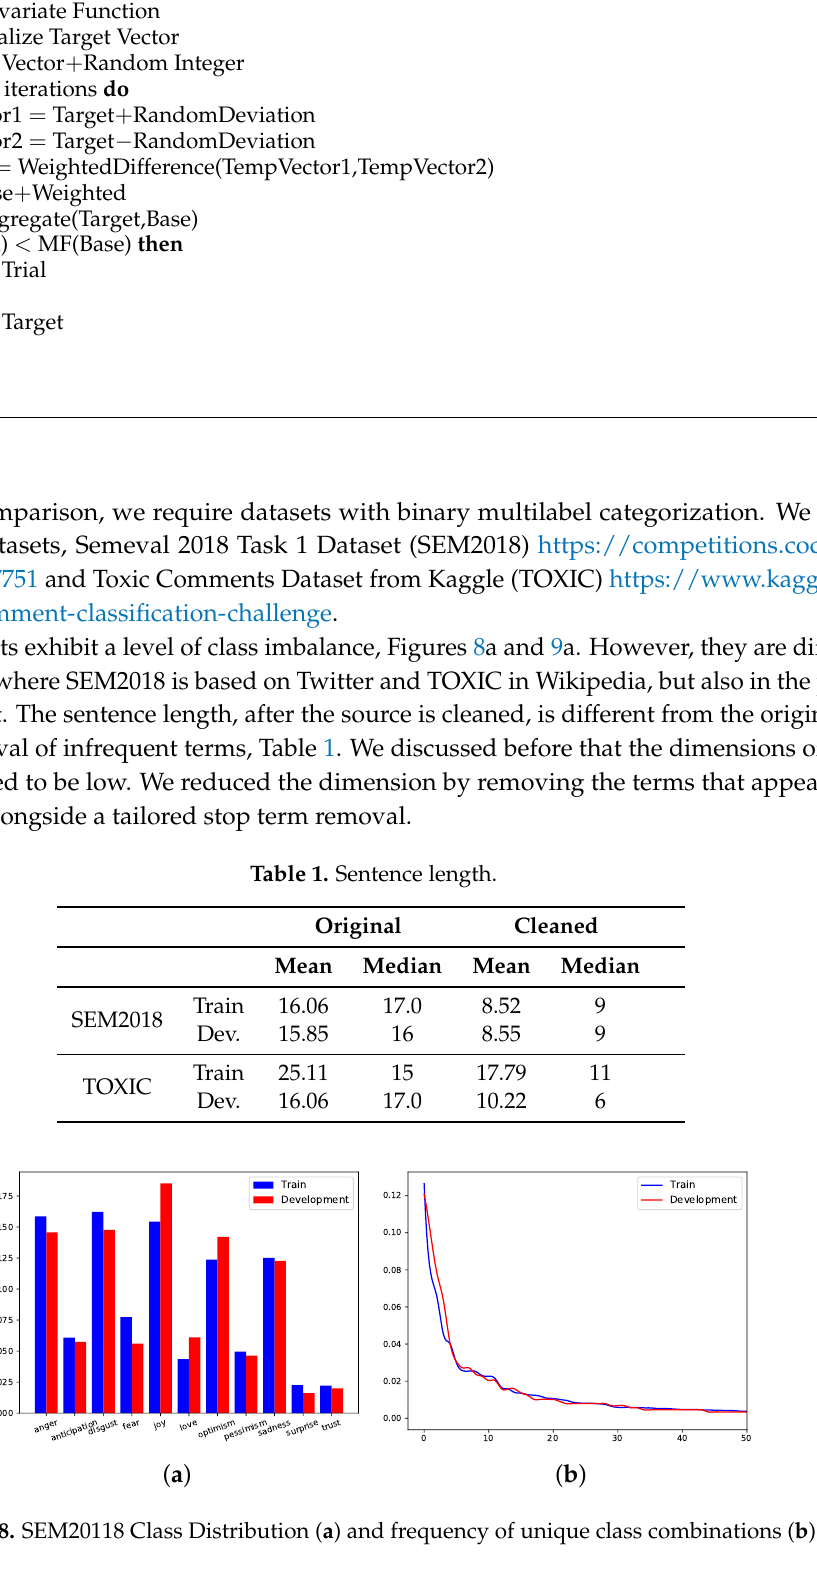
Algorithm 2 Differential Evolution Pseudo-code